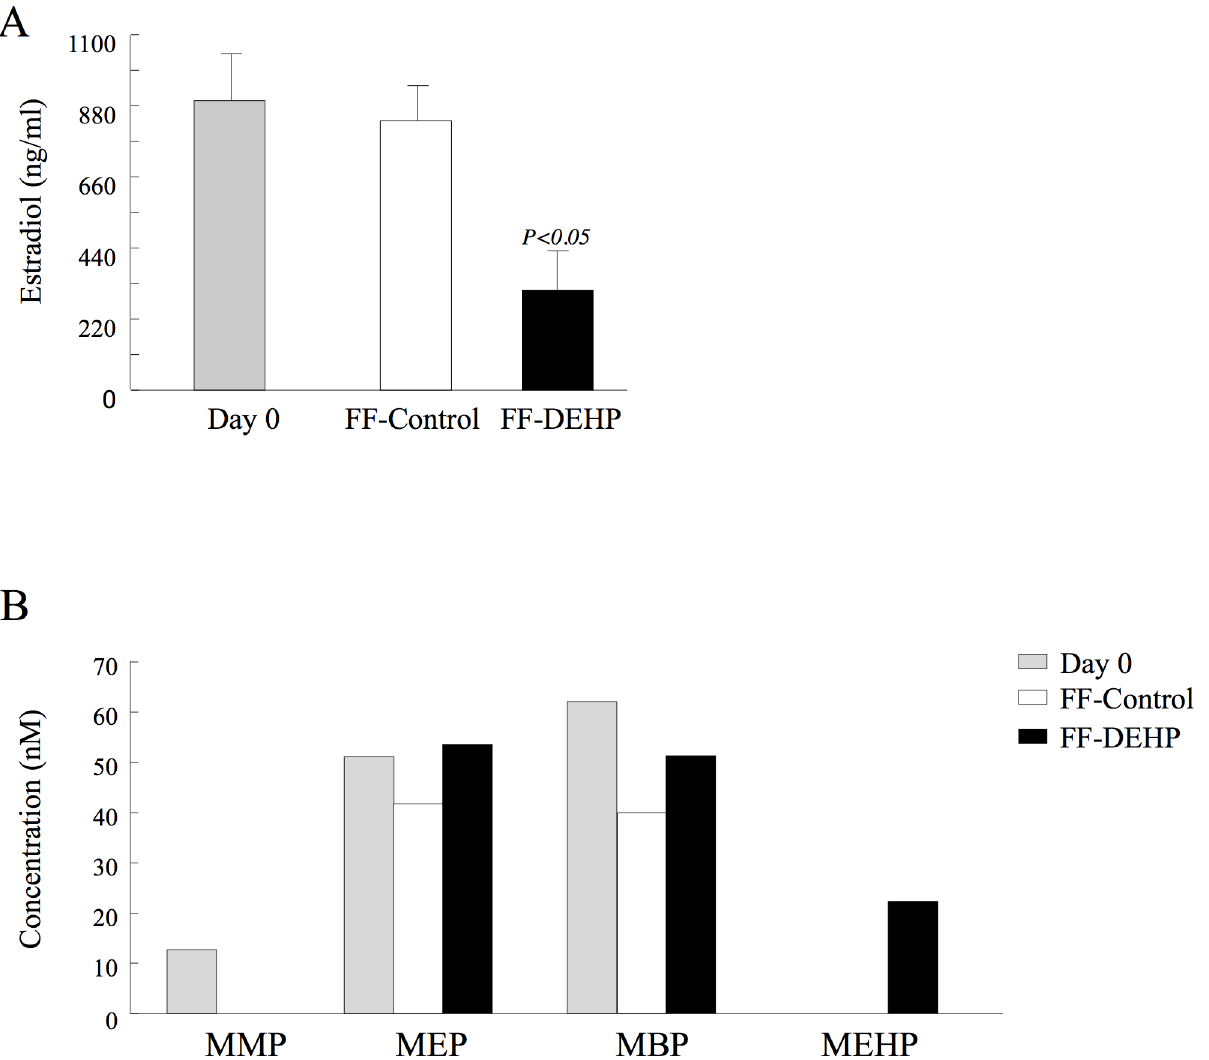
Fig 6. Estradiol and phthalate-metabolite concentrations in the follicular fluid (FF). Cows were tube-fed DEHP or water (control) on days 1 – 3 of the experiment. FFs of the preovulatory follicles were aspirated before (day 0) and after (day 29) DEHP treatment. Data presented as mean ± SEM; P -value indicates for treatment effect within experimental groups on each examined day. (B) Phthalate-metabolite concentrations in FF on day 0 and day 29 of the experiment. MMP, mono-methyl phthalate; MEP, mono-ethyl phthalate; MBP, mono-n-butyl phthalate; MEHP, mono(2-ethylhexyl)